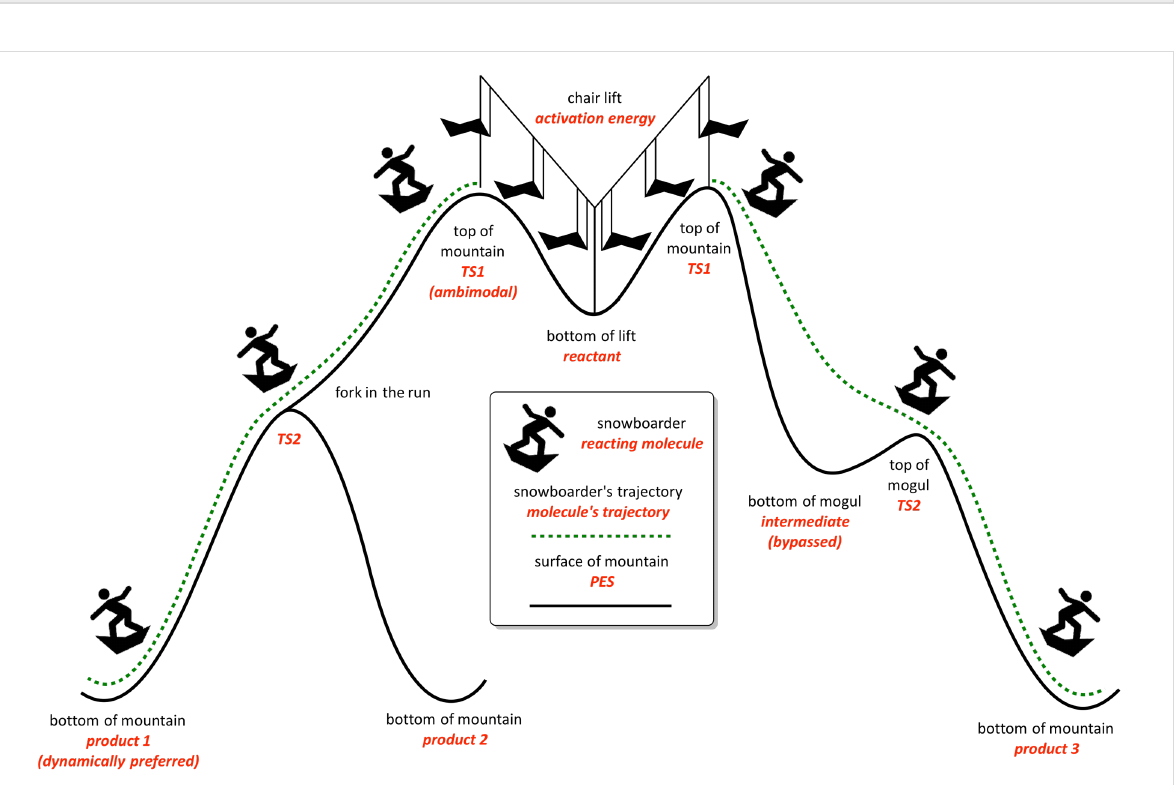
Figure 3: A depiction of the “snowboarder” analogy for reactions displaying non-statistical dynamic effects. Features of a PES that correspond to fea- tures found on the slopes are highlighted in red. This figure illustrates two independent phenomena: Left: formation of a preferred product following an ambimodal TSS due to dynamic matching. Right: an intermediate that is rapidly passed through or bypassed as a result of dynamic